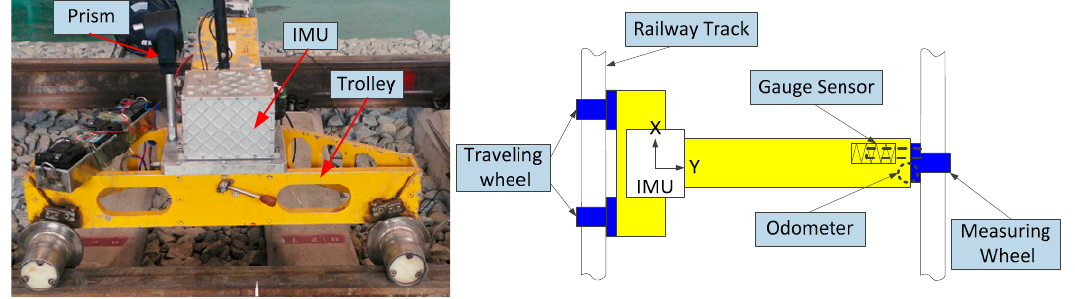
Figure 3. The track irregularity measurement system and its configuration diagram.